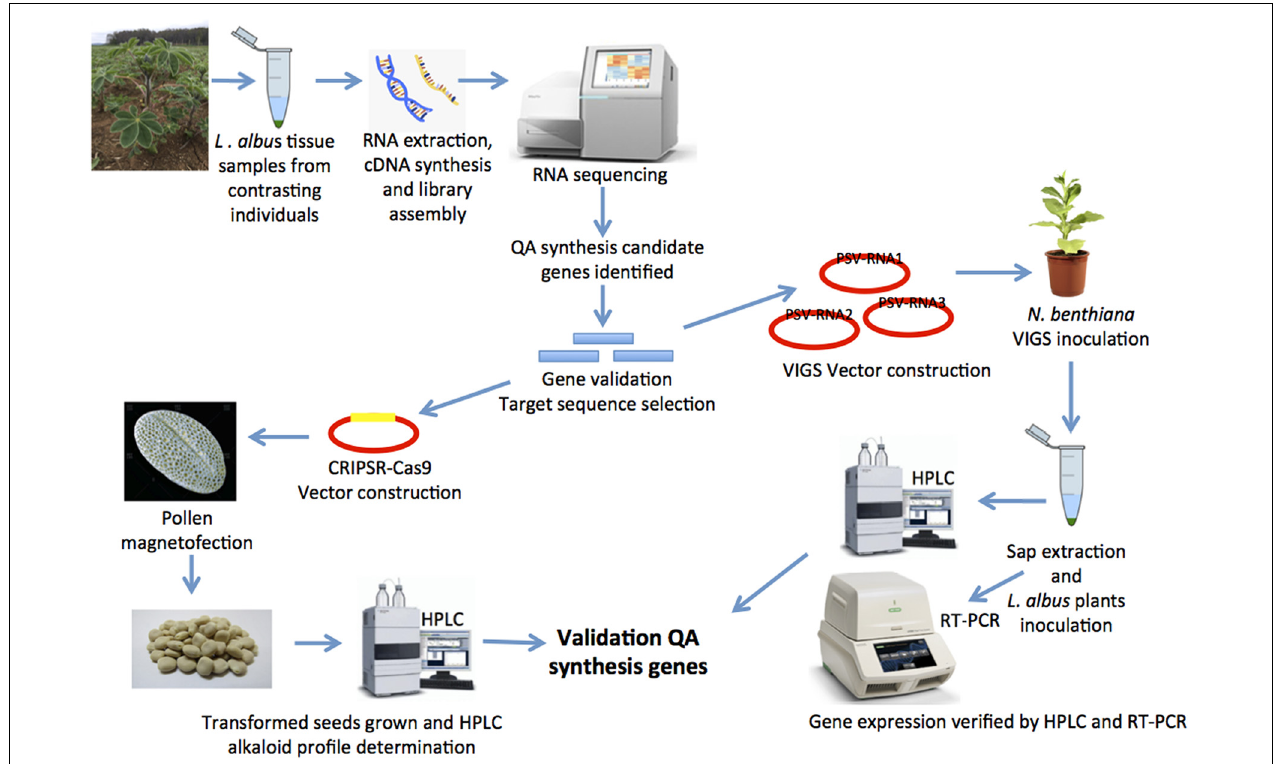
FIGURE 1 | A strategy to unravel quinolizidine alkaloid (QA) synthesis genes using virus induced gene silencing and genome editing, for functional genomics and crop improvement in Lupinus albus.